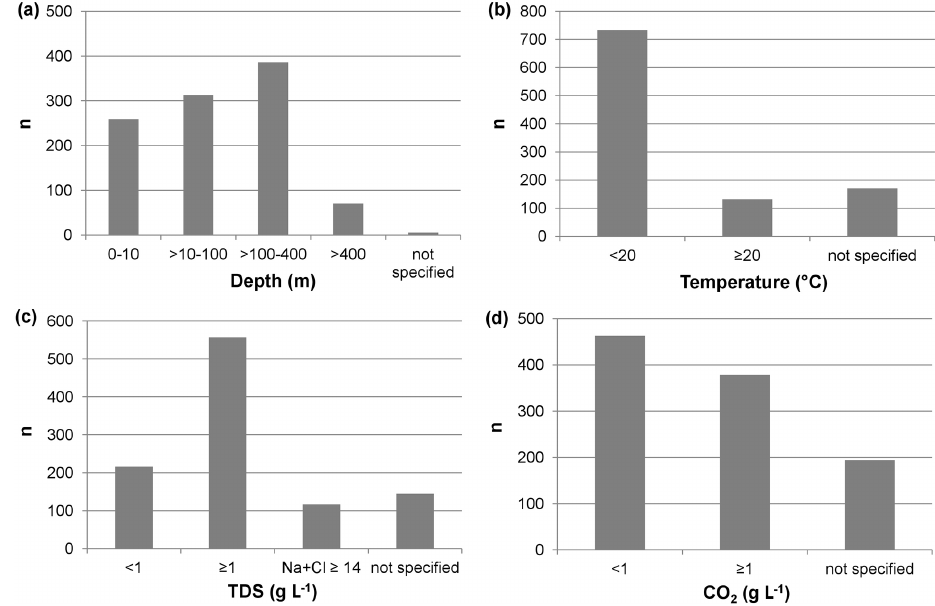
Figure 2. Data distribution with respect to (a) depth of the screened section of the water well, (b) water temperature, (c) concentration of total dissolved solids (TDS) or sodium plus chloride, and (d) the content of free carbon